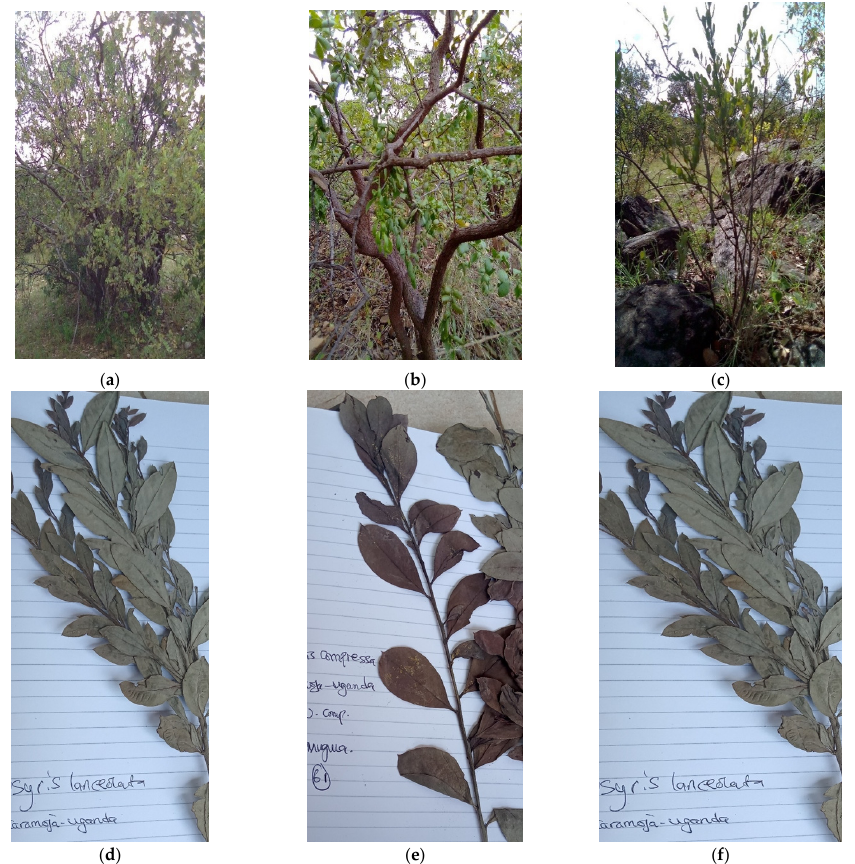
Figure 1. ( a ) Adult tree of O. lanceolata in Uganda; ( b ) “ O. compressa ” (adult tree); (c) O. lanceolata (sapling) [47]; ( d ) specimen of O. lanceolata from Karamoja; ( e ) “ O. compressa ” (Karamoja); ( f ) O. lanceolata (Karamoja) [47].